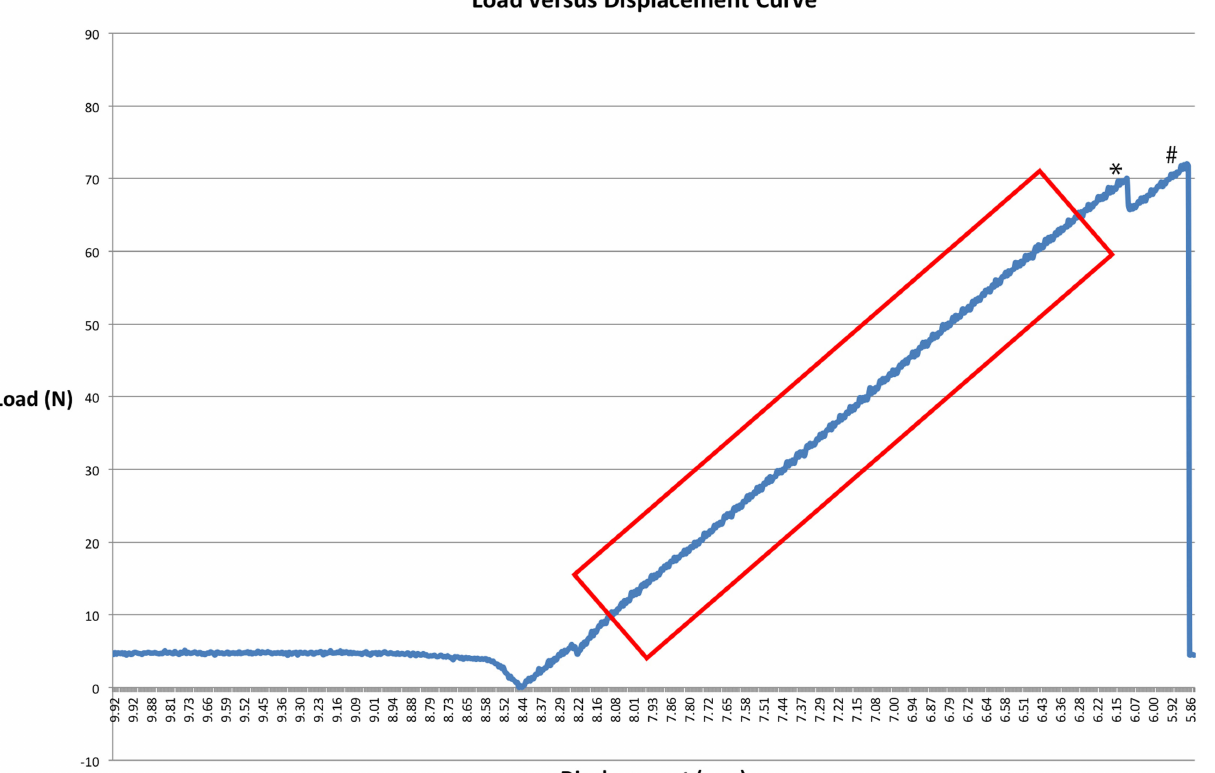
FIGURE 5 | A load–displacement curve of a CO specimen . * denotes a point where load briefly decreased before ultimate failure occurred. This may suggest clinical failure of the fixation construct, a point at which point the